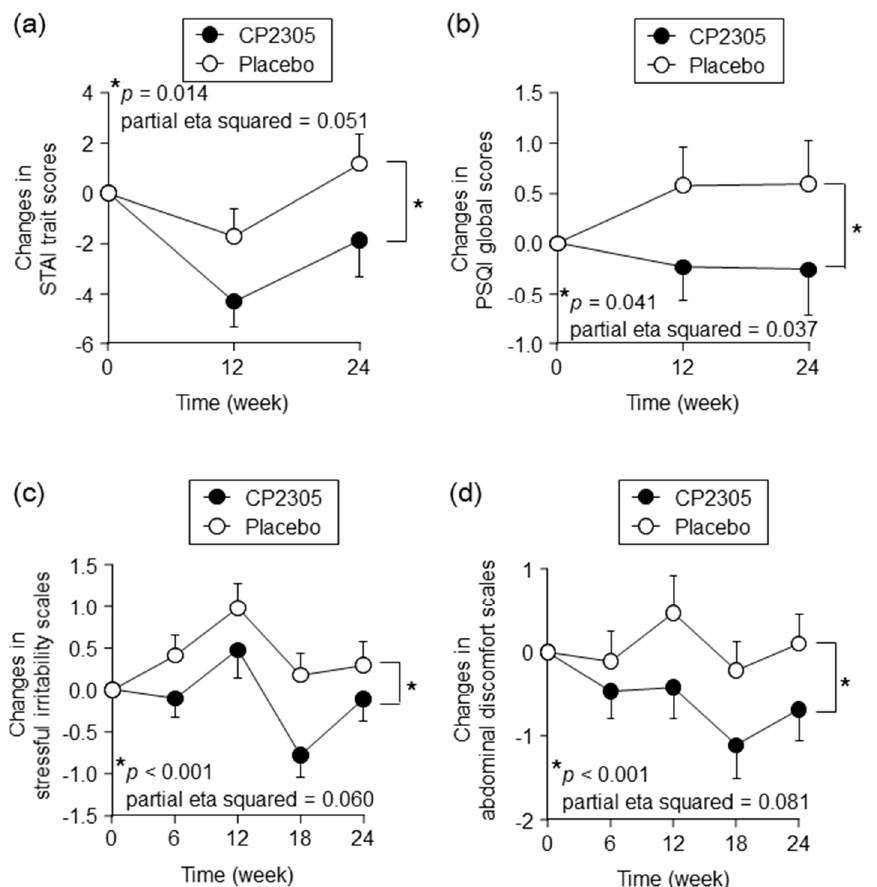
Figure 1. Effects of CP2305 intake on time-dependent changes in questionnaire and visual analog scores. Time-dependent changes in scores of STAI trait anxiety ( a ) and PSQI global score ( b ) in the CP2305 and placebo groups are shown. In addition, the visual analog scales were used to assess stressful irritability ( c ) and abdominal discomfort ( d ). The black circles represent CP2305 and the white represent the placebo groups. Data are presented as the mean ± SEM. The p values and partial eta squared values are shown in each panel; these were determined by repeated-measures ANOVA between the groups without multiple comparison correction. Asterisks indicate overall significance between the groups across time points. * p <